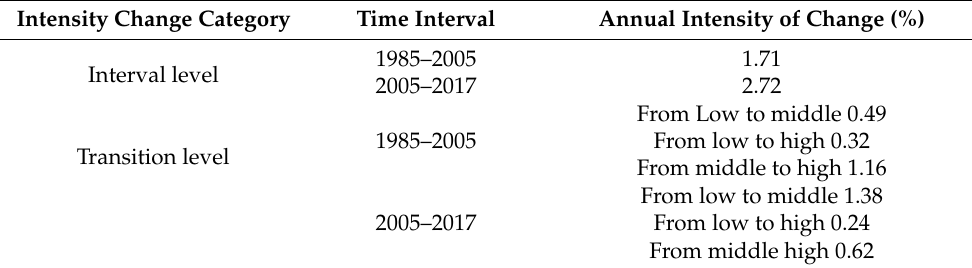
Table 3. Intensity of change.